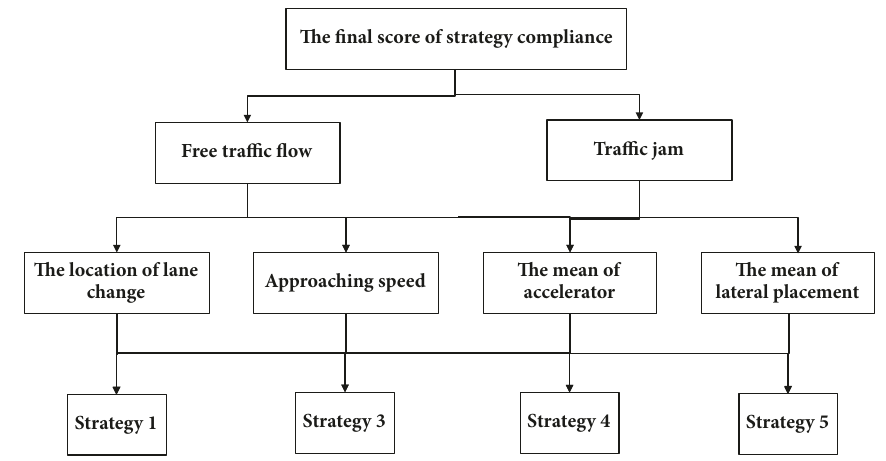
Figure 11: Hierarchical structure in the AHP for strategy compliance. Table 5: Judgment matrices A1 and A2.